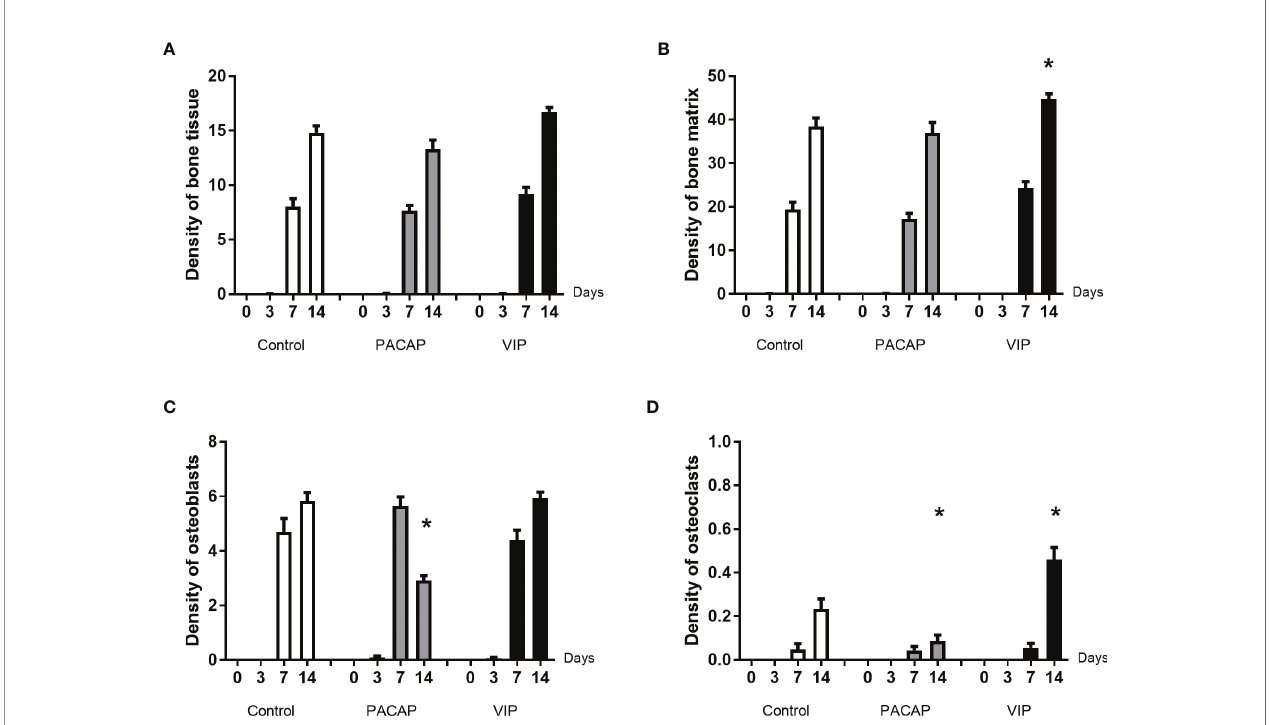
FIGURE 9 | Comparative analysis of area density (%) of bone tissue (A) and its components (B – D) present in the dental alveoli of control mice and treated with VIP and PACAP in the 0, 3-, 7-, and 14-day post-exodontia periods. Results are presented as the means of density for bone matrix, osteoblasts and osteoclasts. Also, the results depict the total density of bone tissue was represented by the sum of bone matrix, osteoblasts, and osteoclasts. The results represent the values of the mean and standard deviation in each of the periods analyzed (* represents the differences between the control